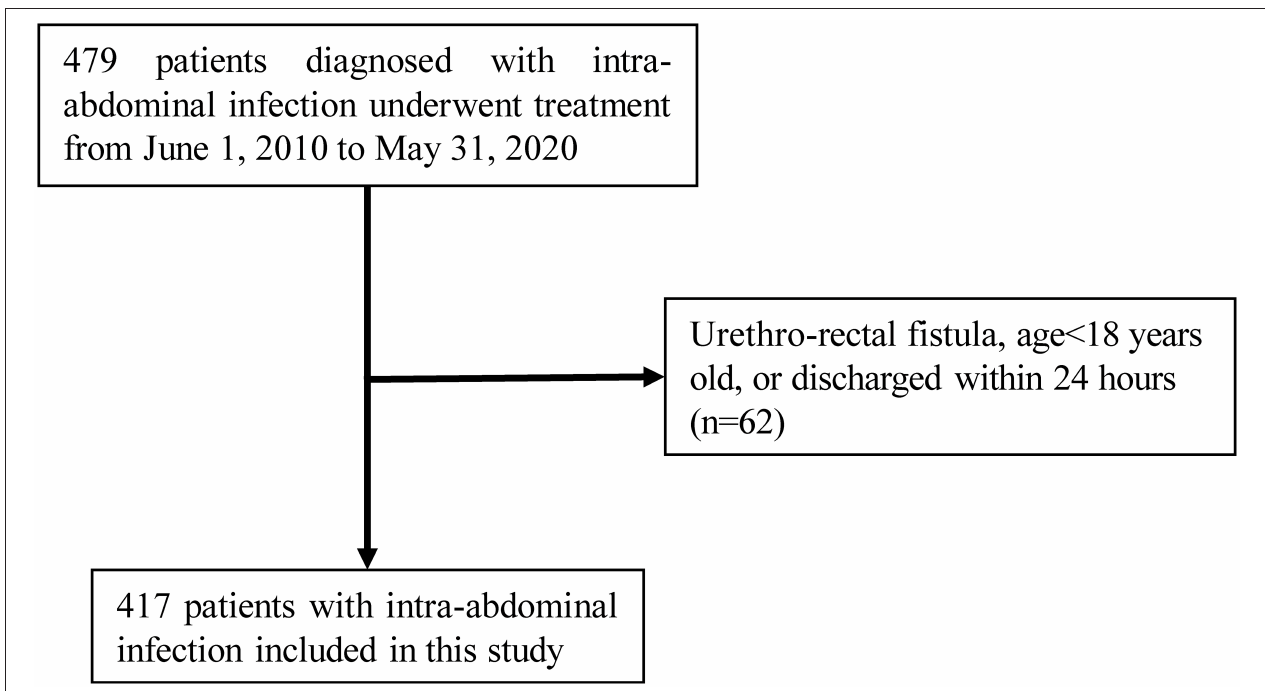
FIGURE 1 | Flow diagram of patient selection according to the inclusion and exclusion criteria.